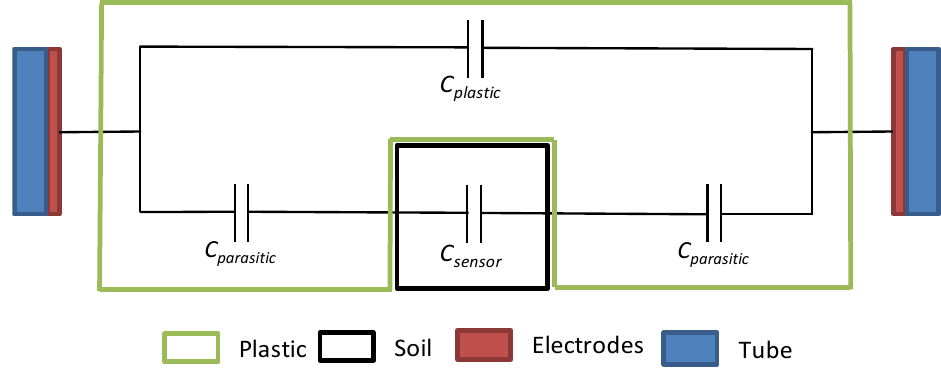
Figure 19. Sensor’s equivalent model considering his coating protection.